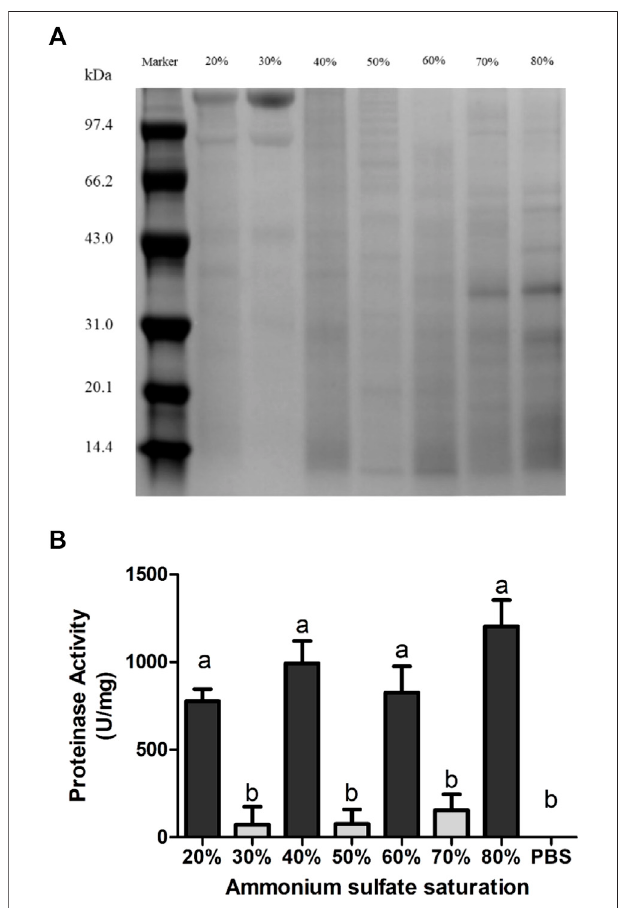
FIGURE 2 | Ammonium sulfate puri fi cation of venom from NnTNV. (A) Nonreducing SDS-PAGE of protein fractions in different ammonium sulfate saturations. The number and location of bands of each fraction were obviously different. Bands of fraction 80% were more clear than others. (B) Proteinaseactivityofdifferentproteinfractions.Fourfractionsshowedsigni fi cant proteinase activity, p < 0.05. Fraction 80% showed the highest activity.